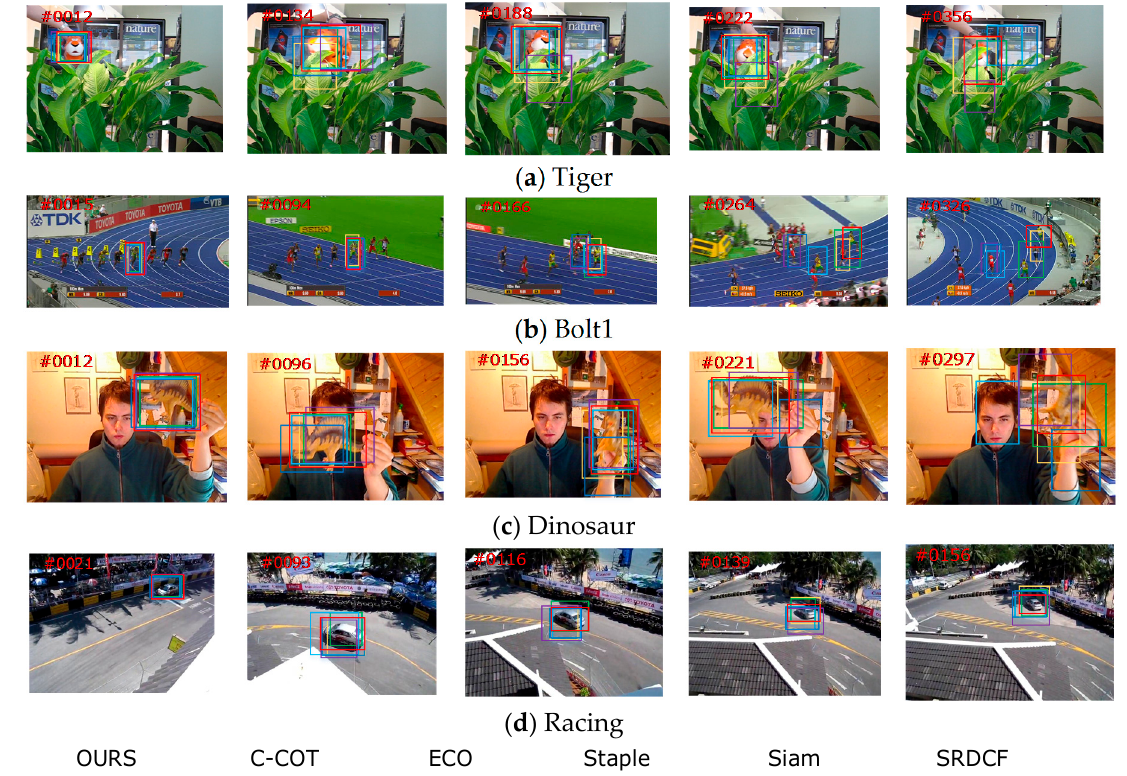
Figure 9. Tracking results of objects undergoing severe occlusion, scale change, and camera change on VOT2016. From top to bottom, the name of the video is ( a ) Tiger; ( b ) Bolt1; ( c ) Dinosaur; ( d )